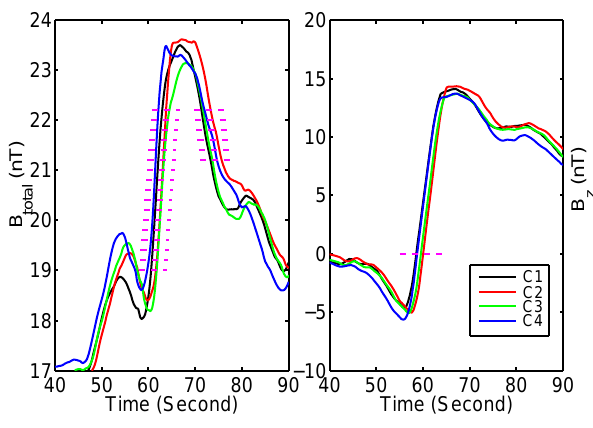
Fig. 3. A 2-D structure observed by FGM/Cluster on 2 October 2003, 00:46:40 UT to 00:47:30 UT. (Left panel) Magnetic strength (Right panel) B z components, as the function of time (both 6-s slid- ing averages at 0.2-s